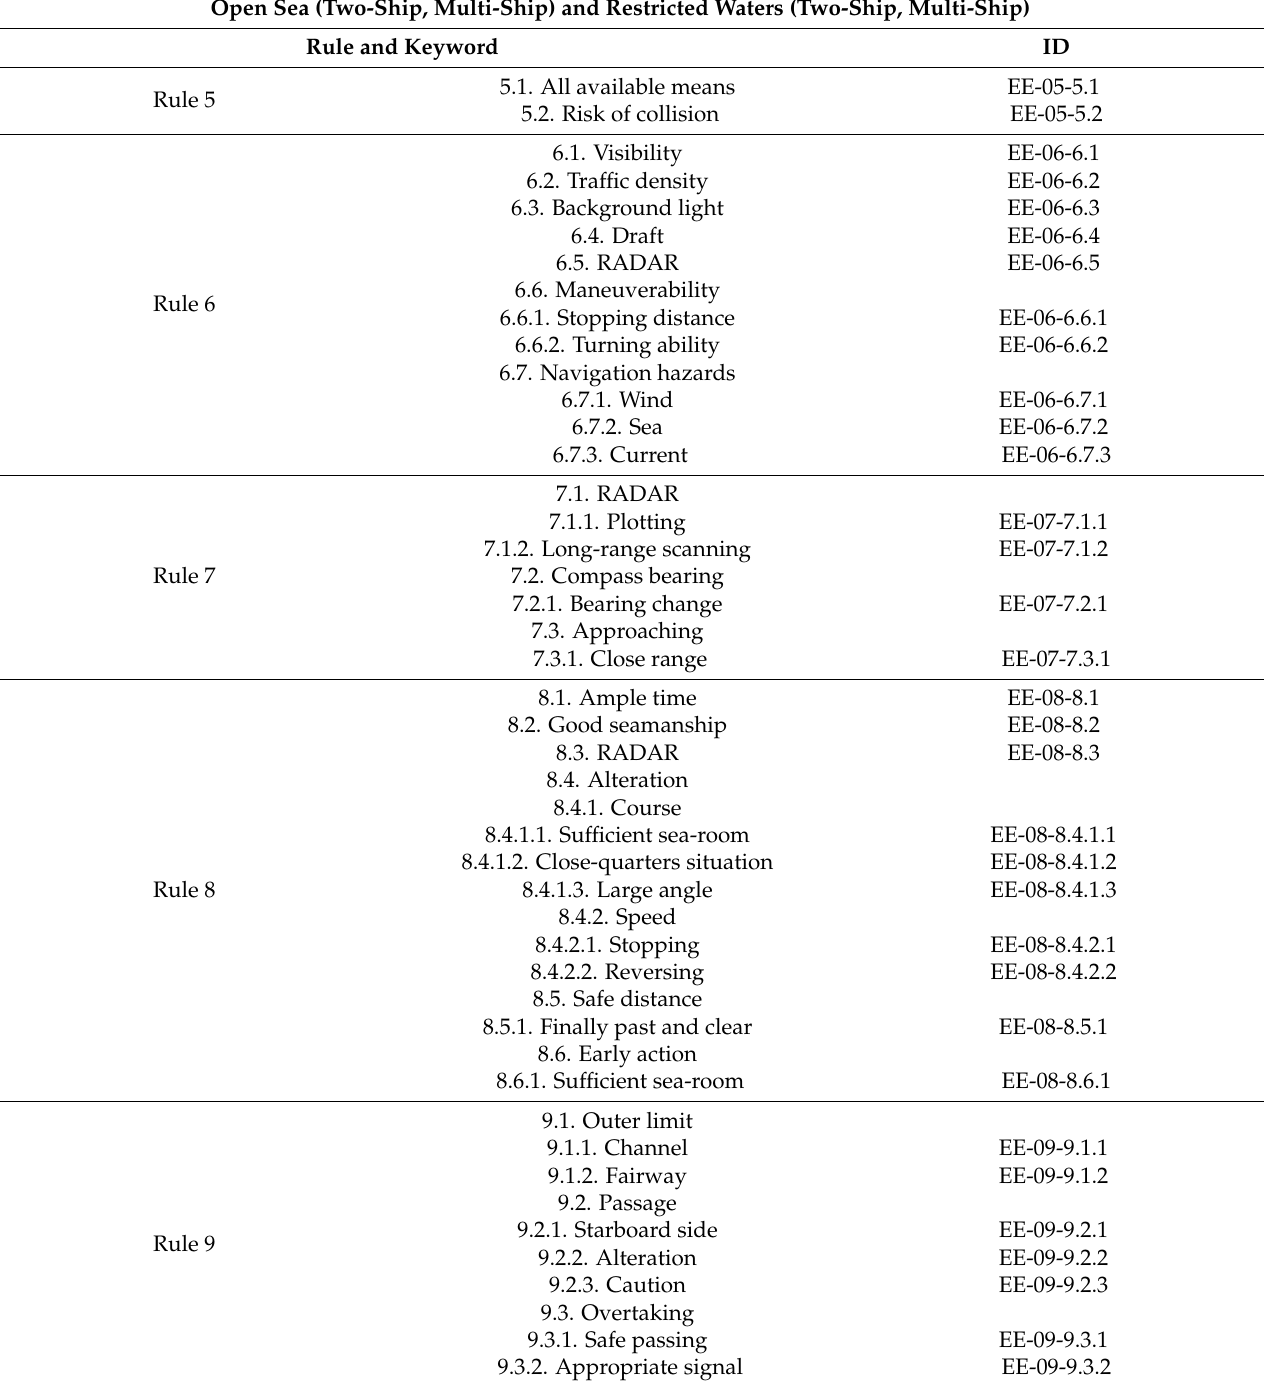
Table A6. Requirements specifications for expert